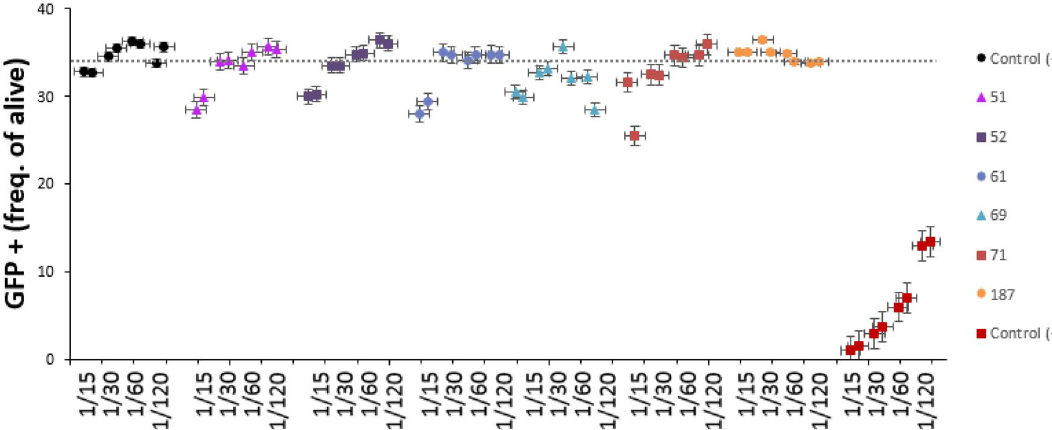
Figure 3. Neutralization assay in 6 dissenting samples: 5 FCM+ /CLIA− samples (51, 52, 61, 69 and 71) and 1 FCM− /CLIA+ sample (187). The reduction of S-protein lentiviral transduced ACE2-cells, due to